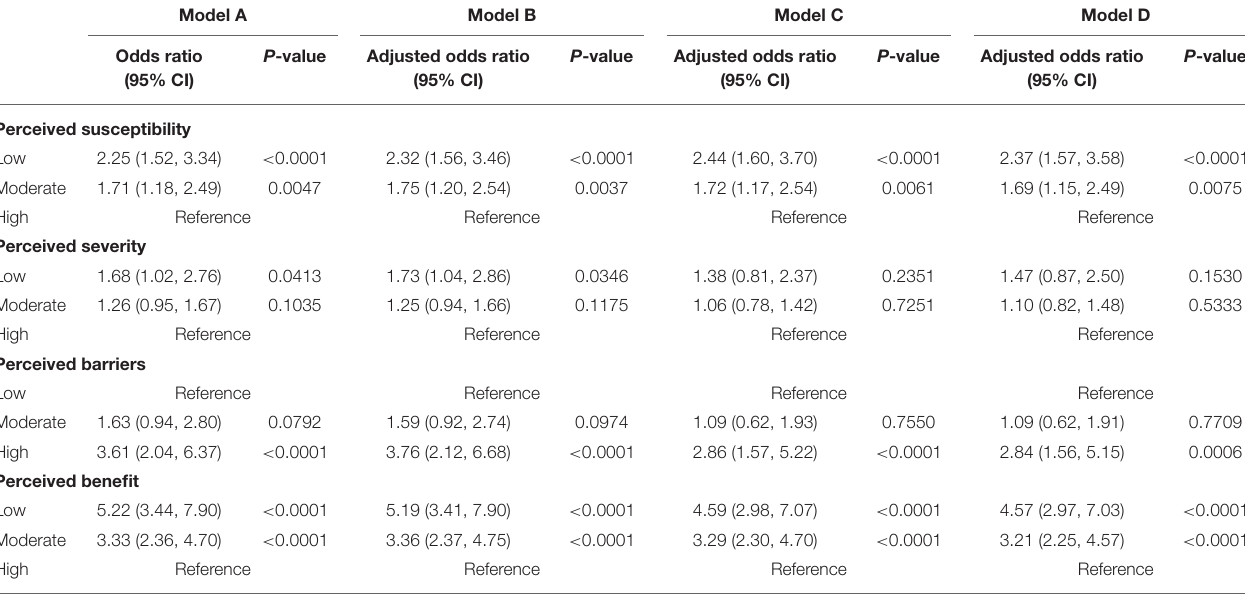
TABLE 3 | The association between risk perception and the risk of COVID-19 vaccine hesitancy to children among 3,011 reproductive women in